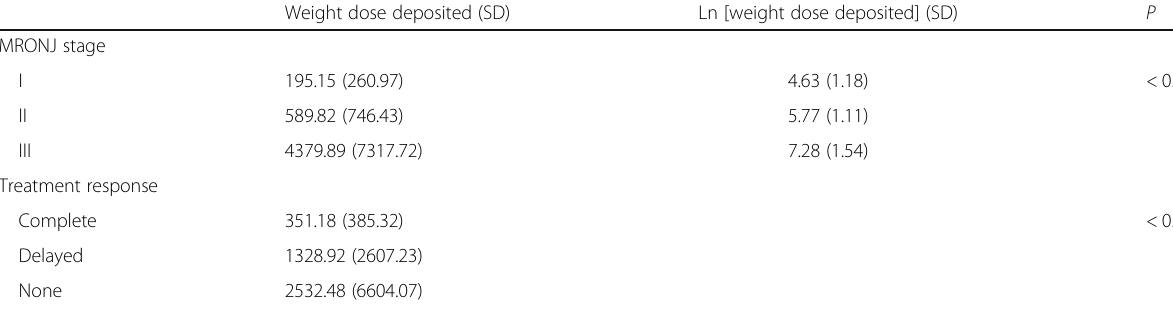
Table 3 Weight dose deposited according to MRONJ Clinical Stage and Treatment Response Weight dose deposited (SD) Ln [weight dose deposited] (SD)